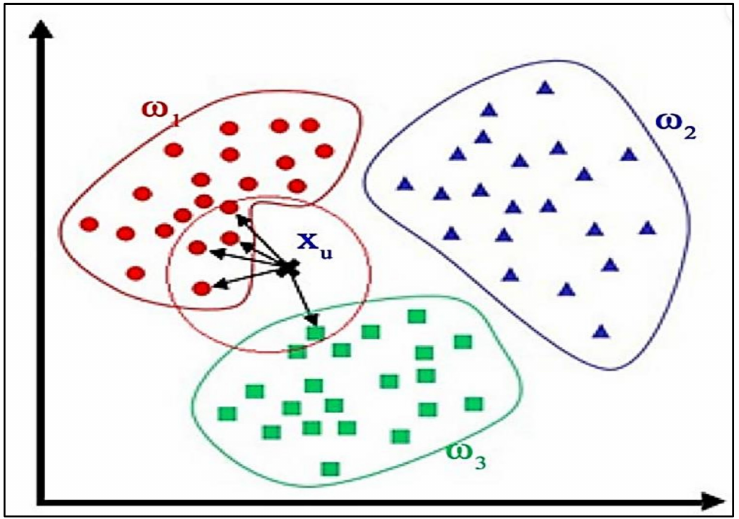
Figure 14. Illustration showing the KNN